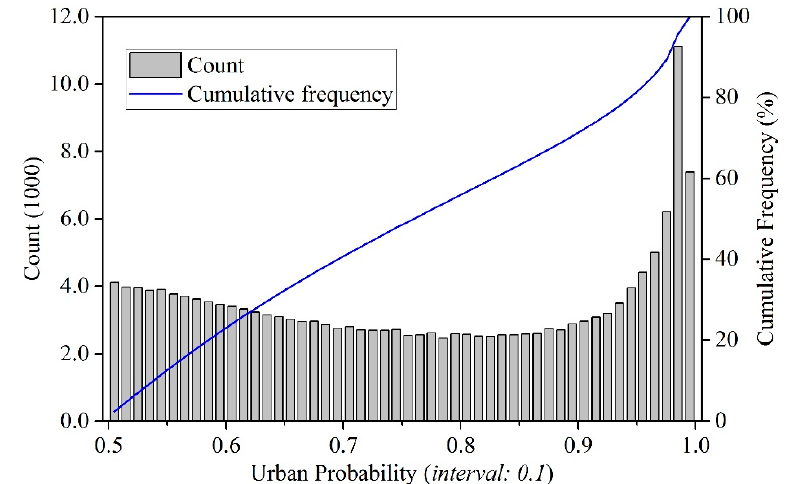
Figure 8. The frequency count and cumulative frequency for urban probability ( ≥ 0.5) for the RF classifier.